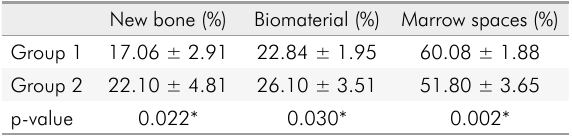
Table 1. Statistical comparison of histomorphometric data in group 1 (n = 9 bone cores) and group 2 (n = 7 bone cores), 2 months after surgery.